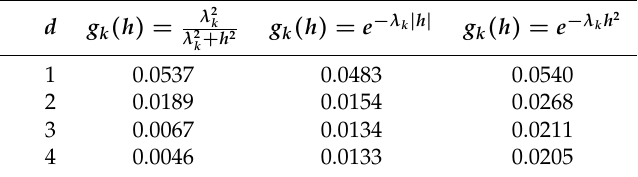
Table 2. Square root errors: silver vs. gold. Number of lags: 150 days.